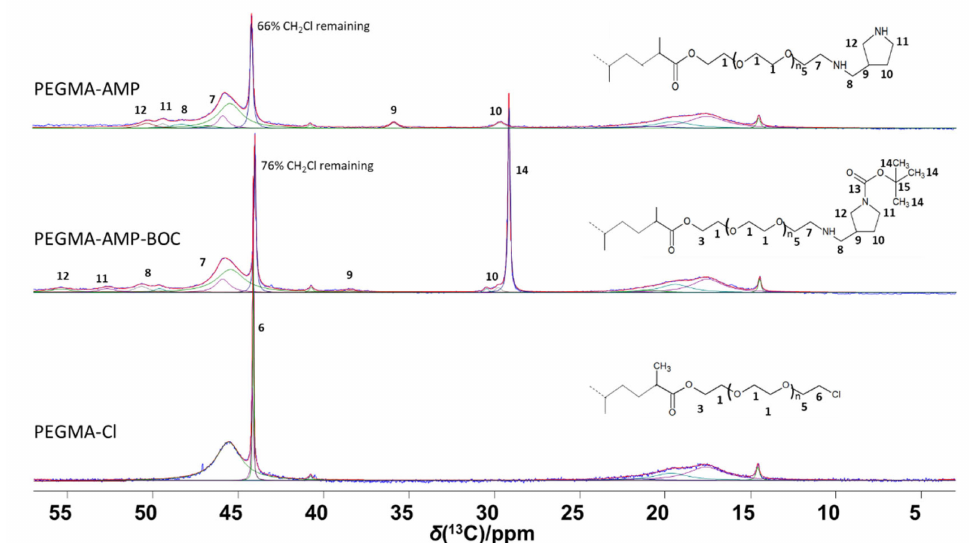
Figure A7. Spectral decomposition of 13 C NMR spectra of (from bottom to top) the chlorine- functionalized PEGMA-Cl, the protected amine-functionalized PEGMA-AMP-Boc-3 and the aminated PEGMA-AMP-3 in the chemical shift region 3–57 ppm.